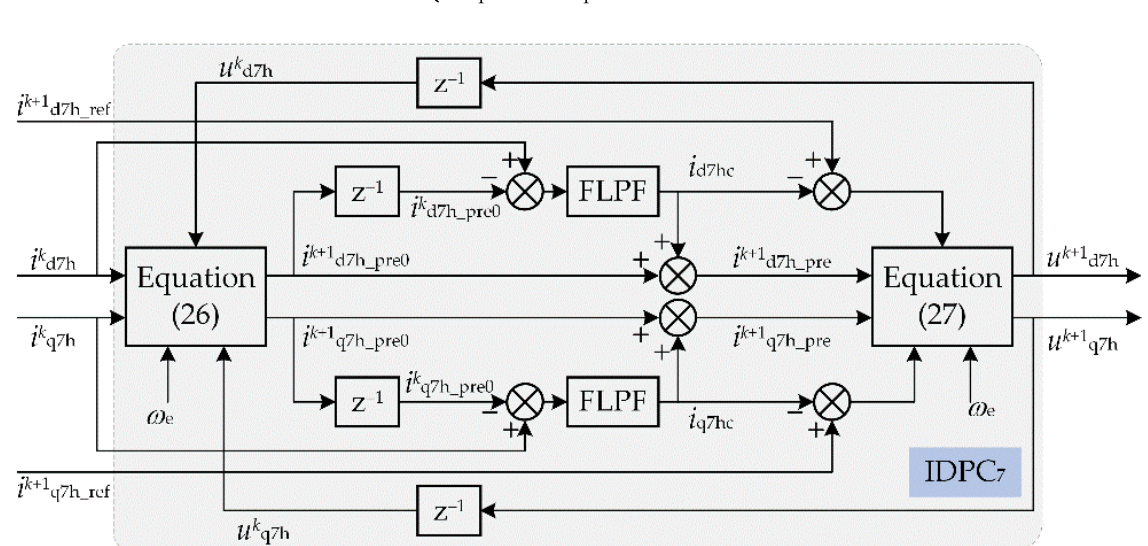
Figure 7. The block diagram of current harmonic controller based on IDPC.